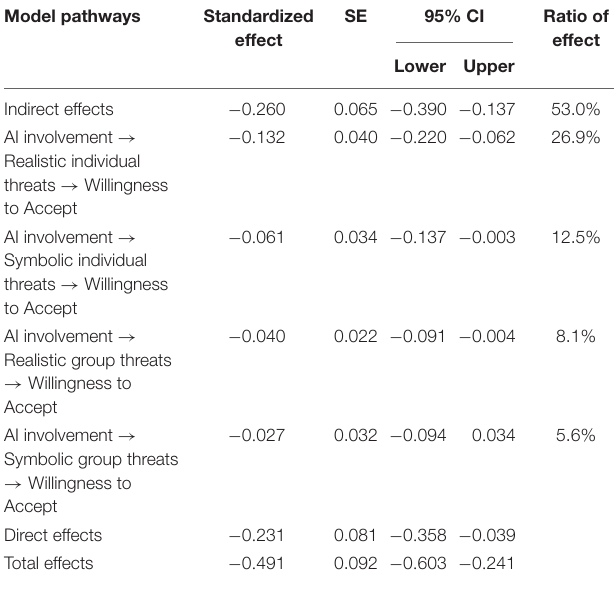
TABLE 5 | The mediating role of realistic individual threats, symbolic individual threats, realistic group threats, and symbolic group threats ( n =